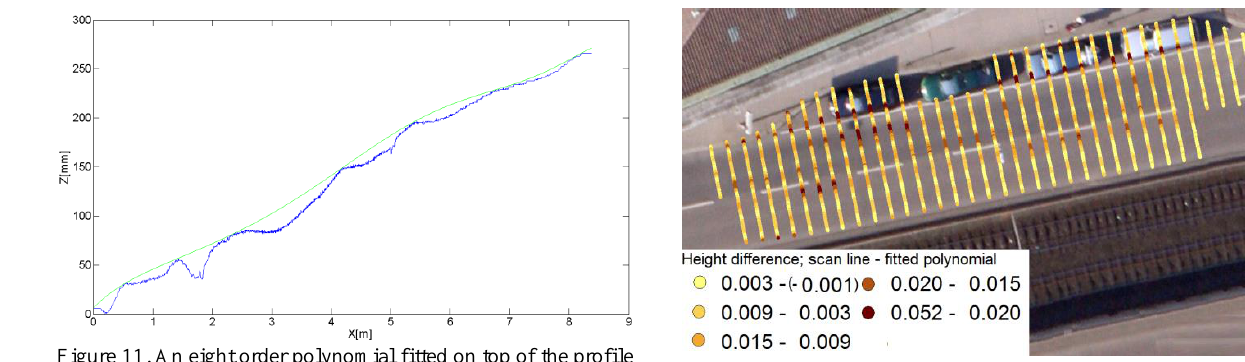
Figure 13. Plot of height differences between scan line and fitted polynomial